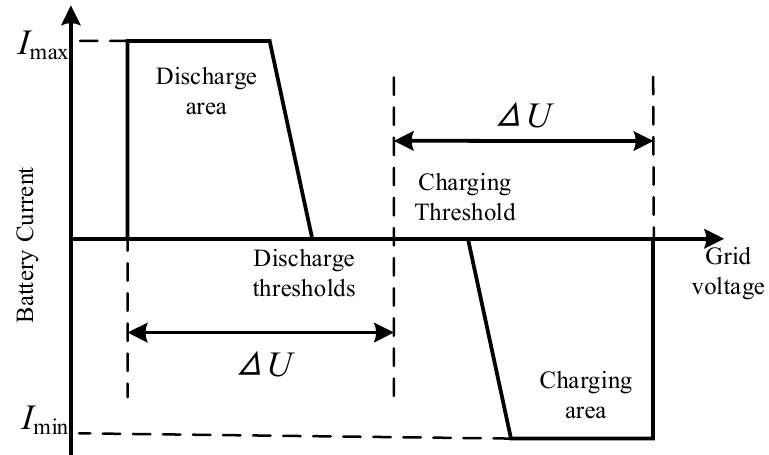
Figure 34. Voltage-based control curves for energy storage.